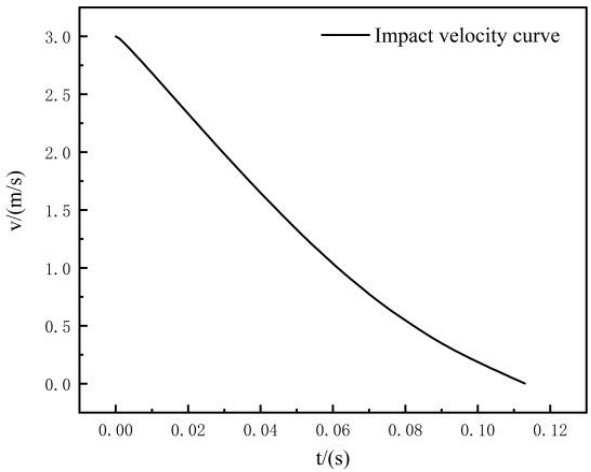
Figure 13. Impact velocity curve.